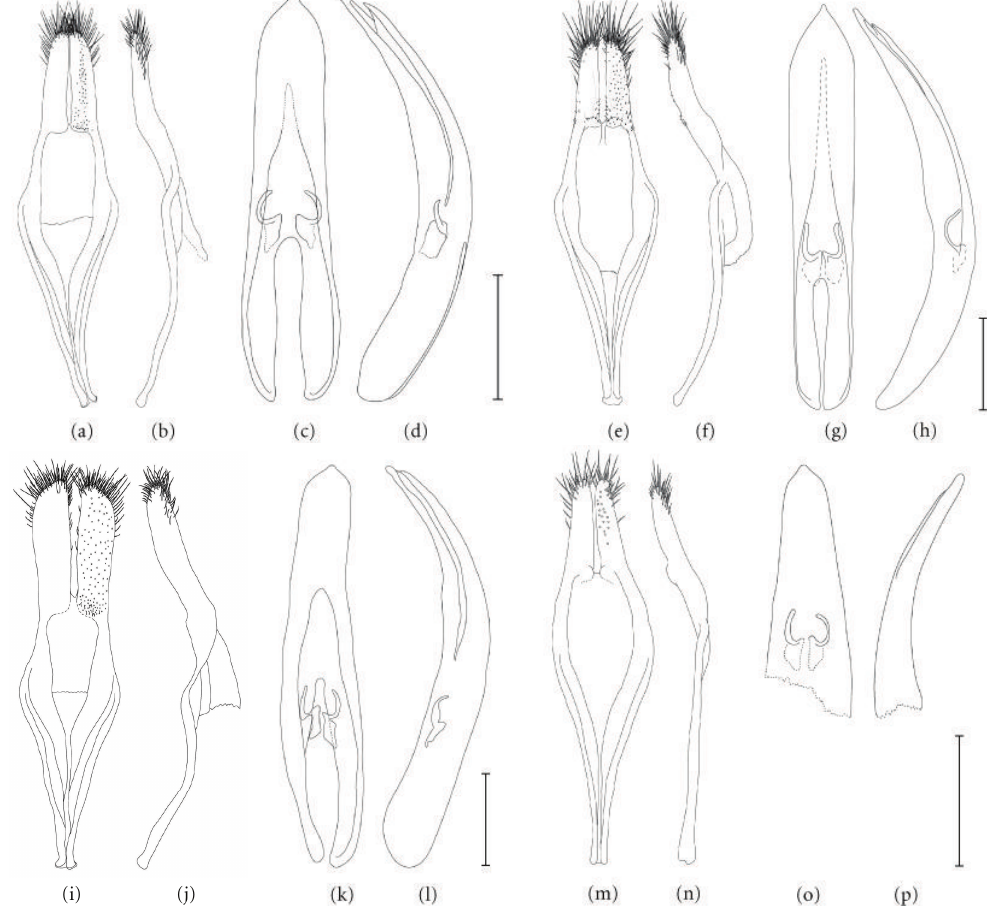
Figure 8: The male genital organ of Agelasta ( Dissosira ) spp. (a–d) A. ( D. ) yonaguni ; (e–h) A. ( D. ) nigrostictica ; (i–l) A. ( D. ) praelongipes ; (m–p) A. ( D. ) kumei ; (a, e, i, m) tegmen in ventral view; (b, f, j, n) ditto in lateral view; (c, g, k, o) median lobe in ventral view; (d, h, l, p) ditto in lateral view. Scale: 1.0